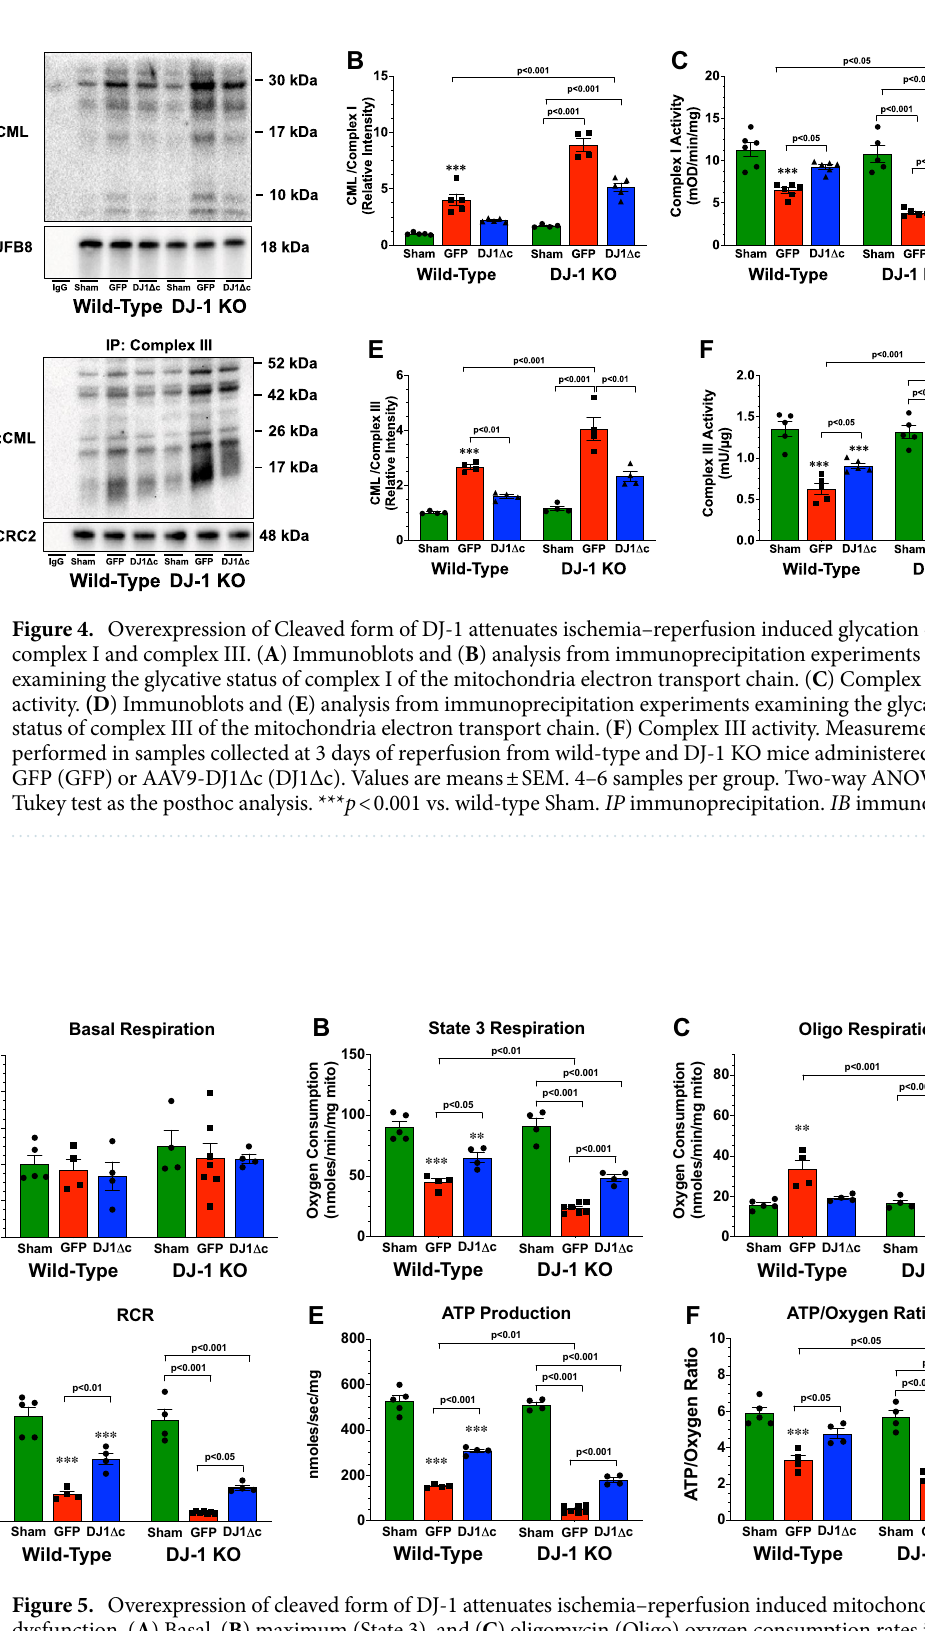
Figure 5. Overexpression of cleaved form of DJ-1 attenuates ischemia–reperfusion induced mitochondrial dysfunction. ( A ) Basal, ( B ) maximum (State 3), and ( C ) oligomycin (Oligo) oxygen consumption rates in the presence of pyruvate and malate. ( D ) Respiratory control ratio (RCR; State 3/oligomycin). ( E ) ATP production rates. ( F ) Efficiency of ATP synthesis [ATP produced per oxygen consumed (ATP/O)]. All measurements were performed in samples collected at 3 days of reperfusion from wild-type and DJ-1 KO mice administered AAV9- GFP (GFP) or AAV9-DJ1Δc (DJ1Δc). Values are means ± SEM. 4–7 samples per group. Two-way ANOVA with a Tukey test as the posthoc analysis. ** p < 0.01 and *** p < 0.001 vs. wild-type